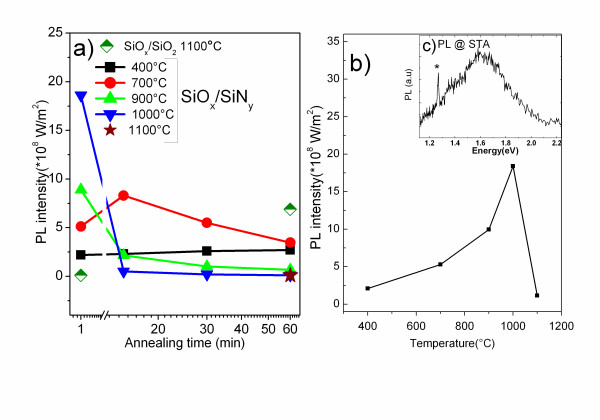
Photoluminescence. (a) Maximum PL intensity [IPL] of SiOx/SiNy MLs vs TA and tA, and SiOx/SiO2 at 1,100°C; (b) PL spectra of STA SiOx/SiNy MLs; (c) IPL vs TA for tA = 1 min. The asterisk represents the peak from second order emission of laser.